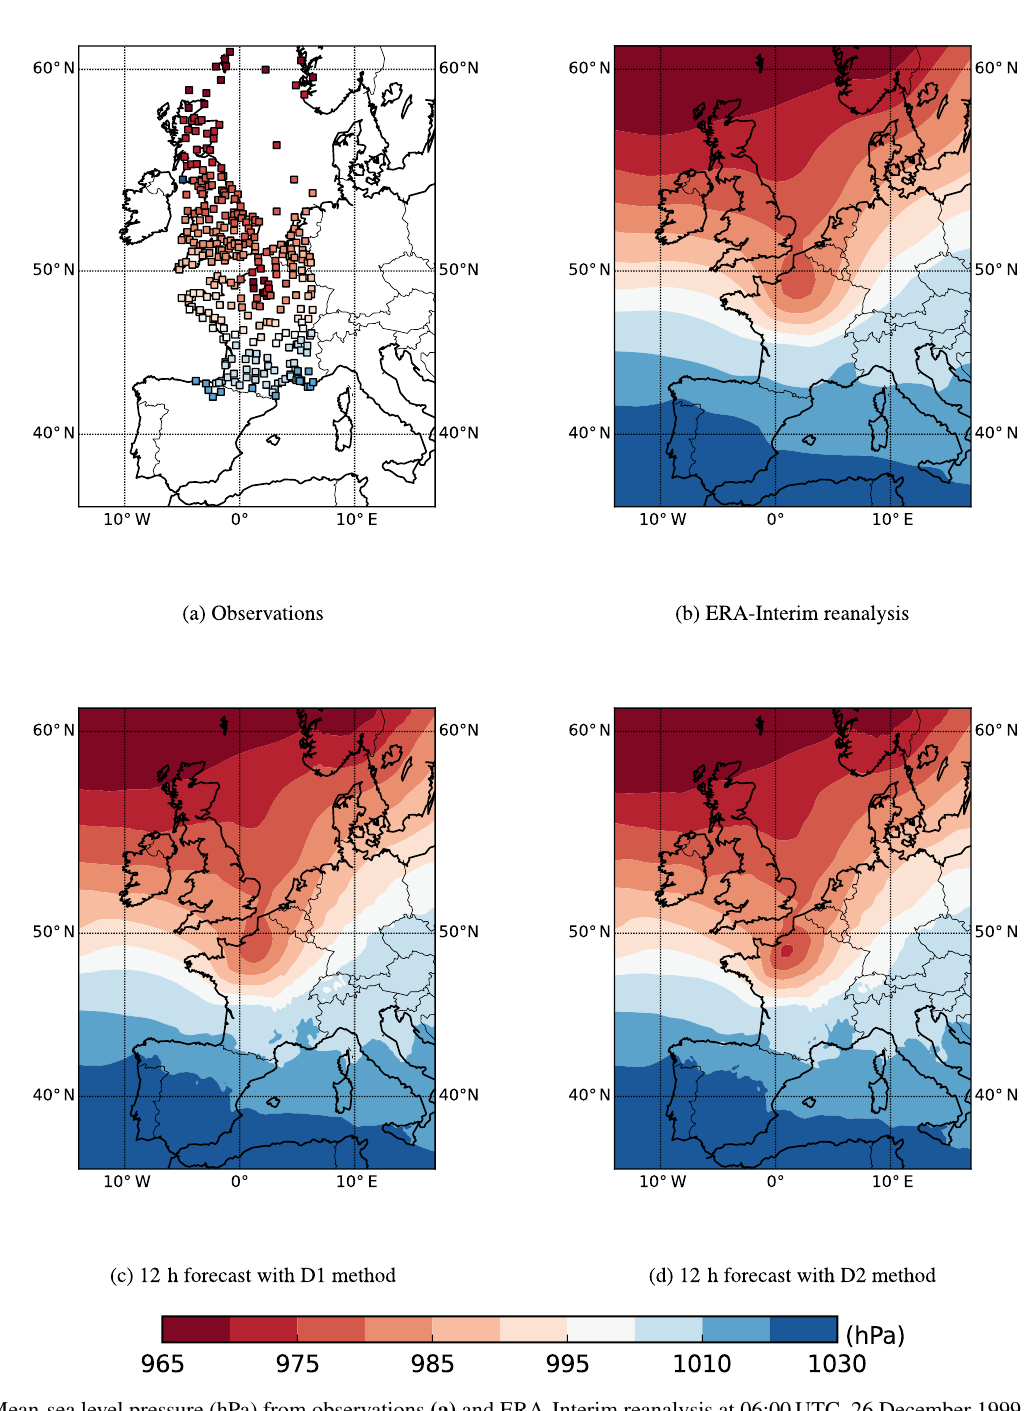
Figure 3. Mean-sea level pressure (hPa) from observations (a) and ERA-Interim reanalysis at 06:00UTC, 26 December 1999 (b) , from 12h forecast using the D1 (c) and D2 (d) downscaling methods at 18:00UTC, 25 December